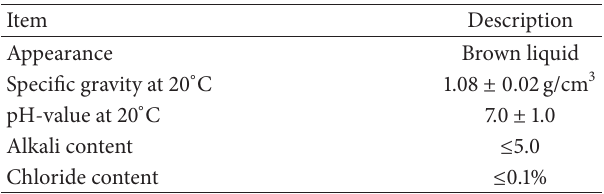
Table 3: Technical data of Glenium 51 used as superplasticizer.